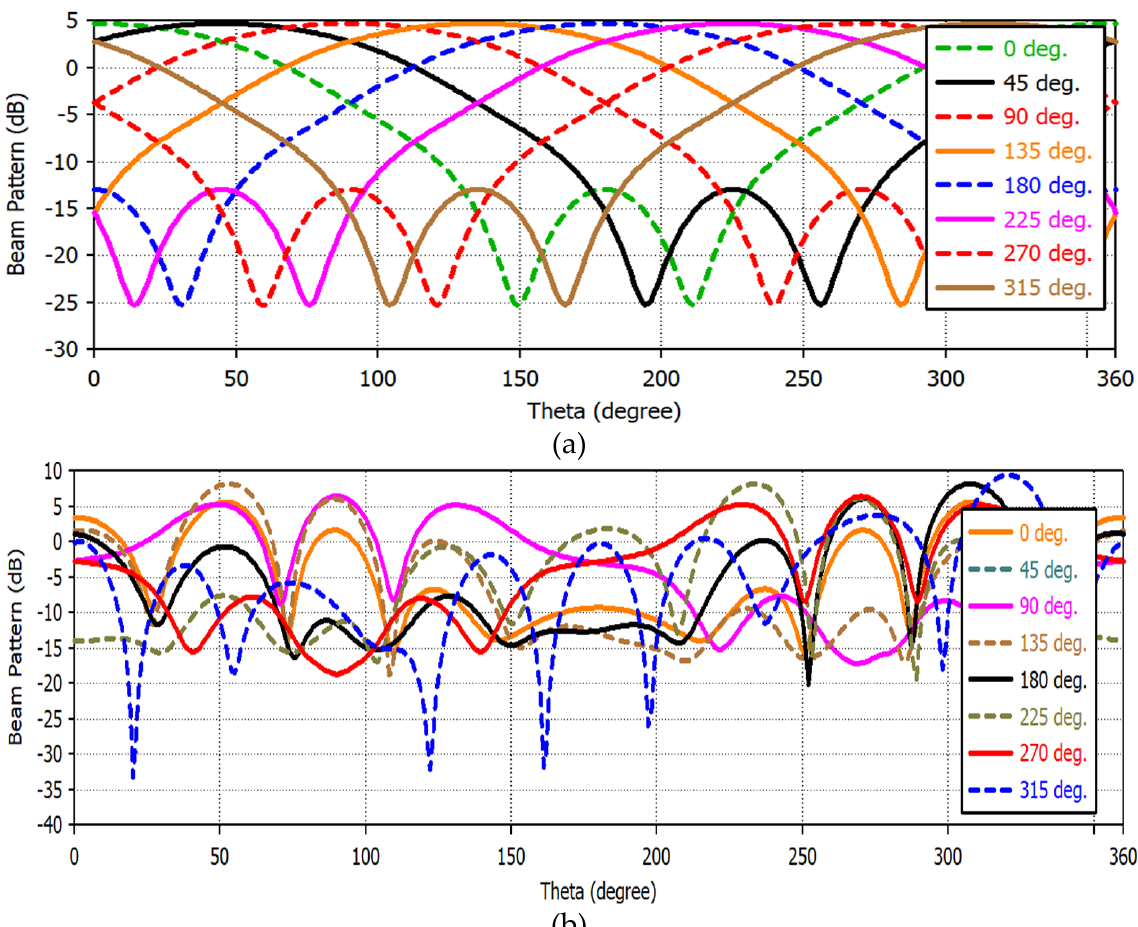
Figure 10. Beam scanning at different directional angle: ( a ) BS of the ESPAR antenna at respective directions; ( b ) BS at 270 (cid:2868) followed by angular beam direction at each 45 (cid:2868) interval.